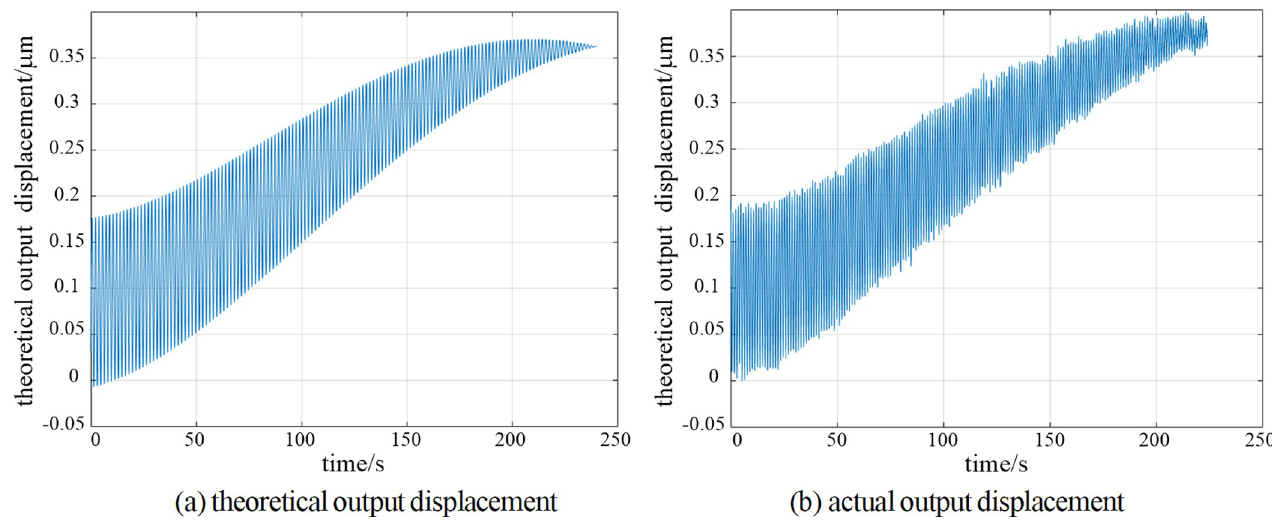
Fig 9. The theoretical and actual output